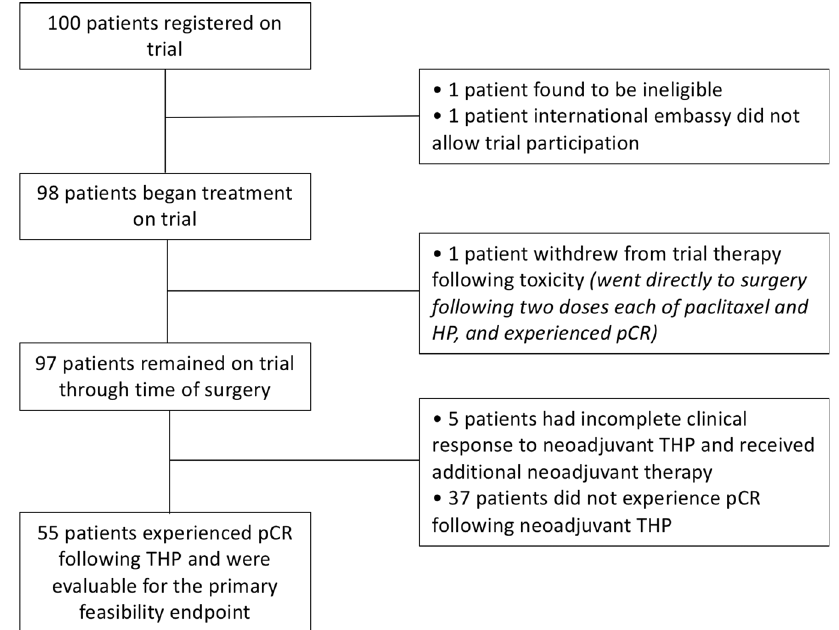
Fig. 1 Trial fl ow diagram. pCR pathologic complete response, THP paclitaxel/trastuzumab/pertuzumab.